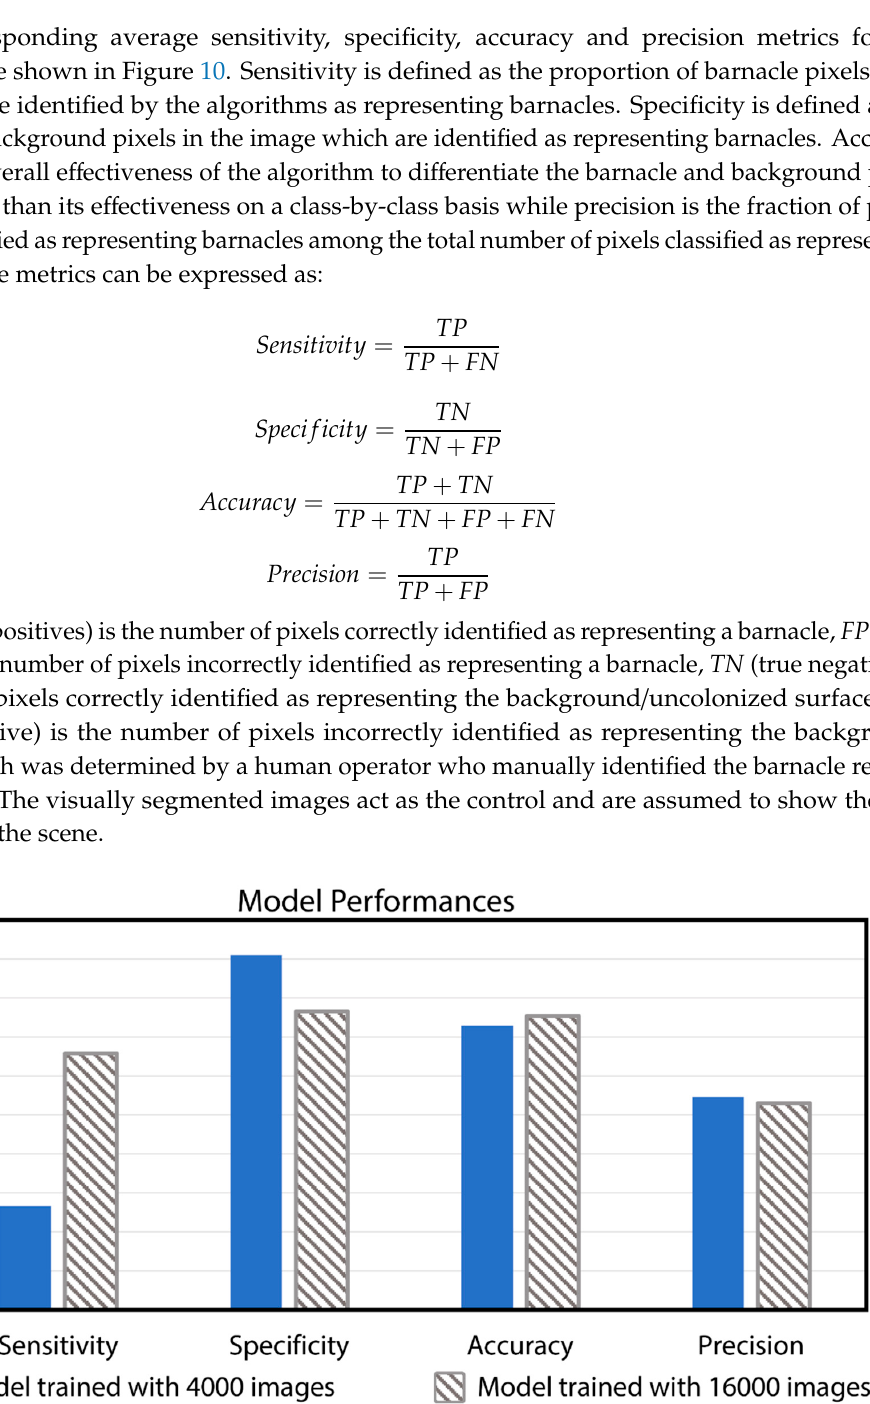
Figure 10. Performance evaluation of the CNN models trained using 4000 and 16,000 synthetic images for evaluation metrics comprising of Sensitivity, Specificity, Accuracy and Precision¸ when averaged over 10 sample video frames.